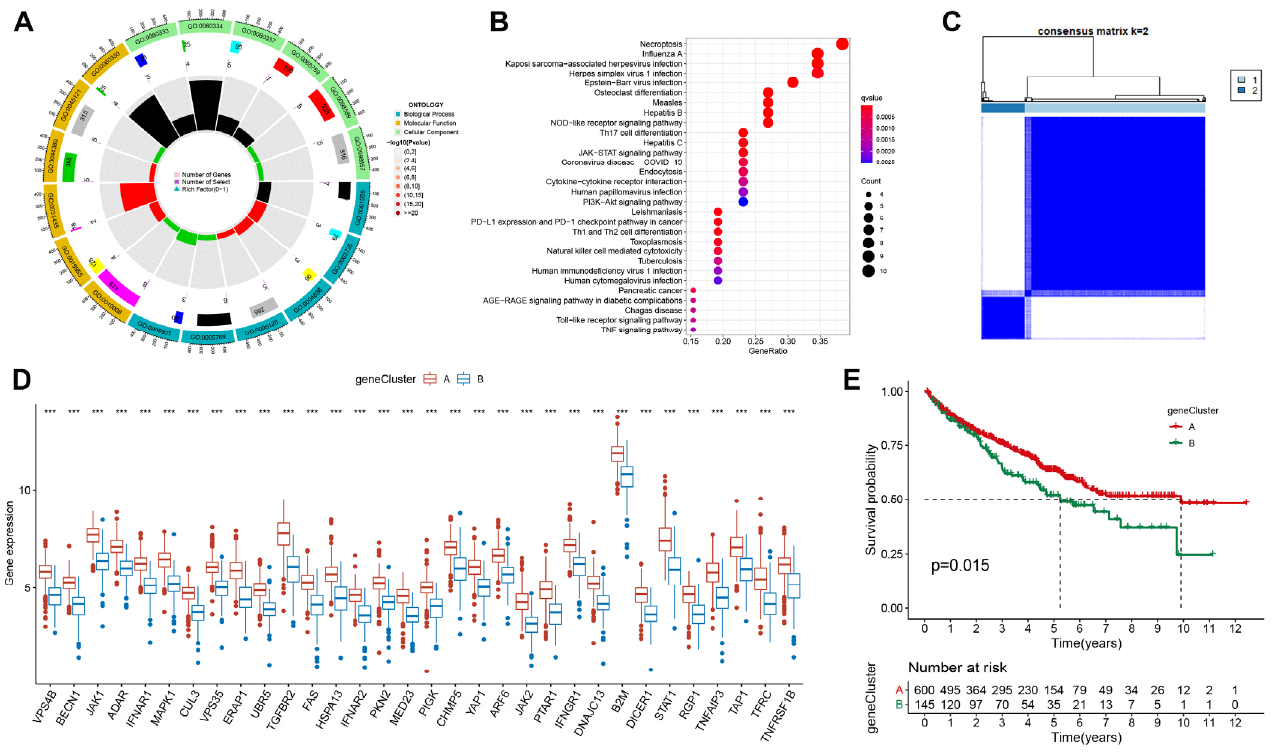
Figure 3. Explore the potential biological function of immune escape-related genes. ( A ) GO enrich- ment of immune escape-related differential genes (DEGs) between IER A and IER B clusters. ( B ) KEGG enrichment of differential genes (DEGs) between IER A and IER B clusters. ( C ) Quadratic consensus clustering of ccRCC sample usage based on DEGs. ( D ) Expression difference of DEGs between geneCluster A and geneCluster B (***: p < 0.001). ( E ) Overall survival curves of geneCluster A and geneCluster B using the Kaplan–Meier method.